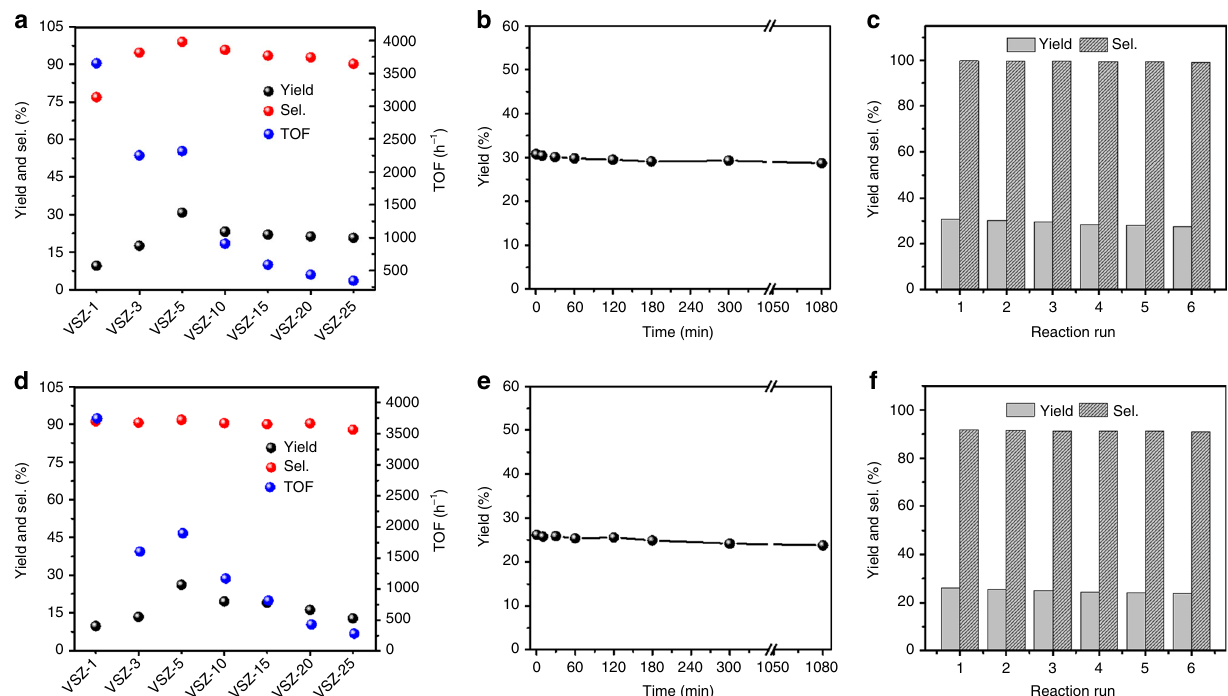
Fig. 3 Catalysis performance of VSZ- n . Yield, selectivity and TOF of VSZ- n in the hydroxylation of a benzene and d toluene; Yield as a function of reaction time in the VSZ-5 catalyzed hydroxylation of b benzene and e toluene; Catalytic reusability of VSZ-5 in the hydroxylation of c benzene and f toluene.